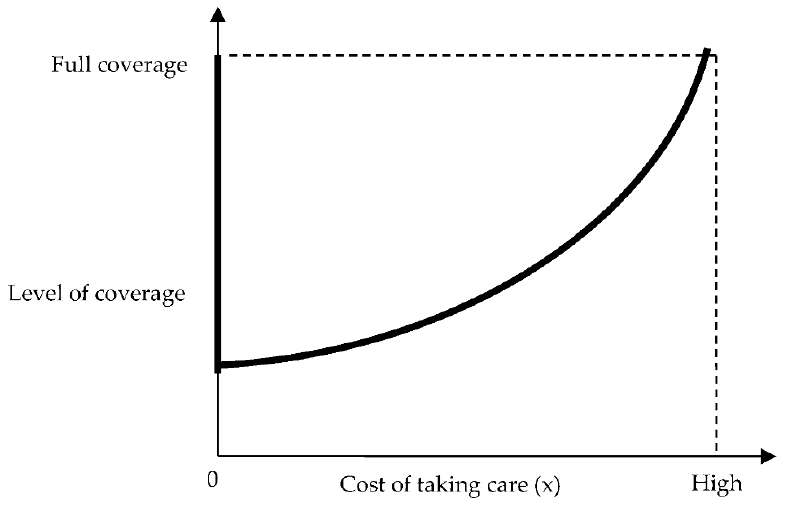
Figure 1. Level of